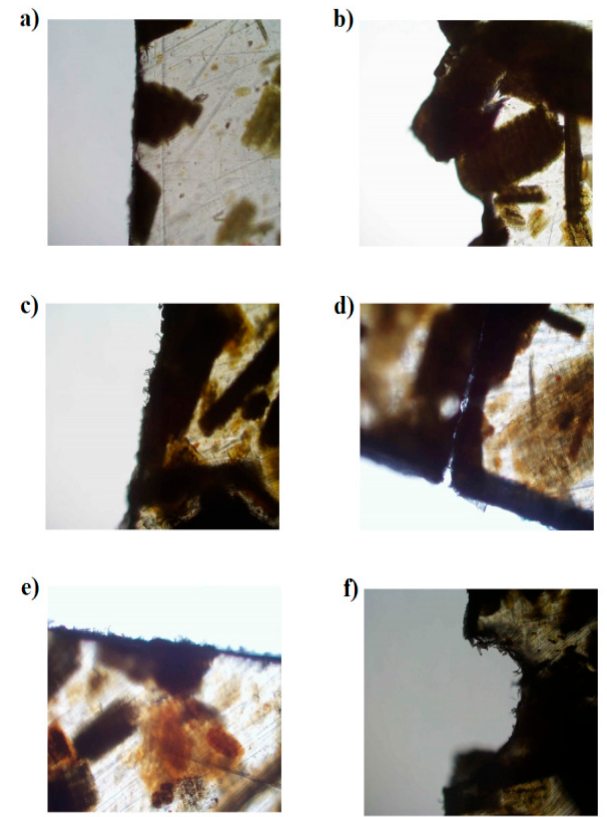
Figure 16. Biodegradation of biopolymers during 21 days of composting process: LDPE + 10% RH ( a ) at the beginning of composting and ( b ) after composting process; LDPE + 40% RH ( c ) at the beginning of composting and ( d ) after composting process; LDPE + 50% RH ( e ) at the beginning of composting and ( f ) after composting process.